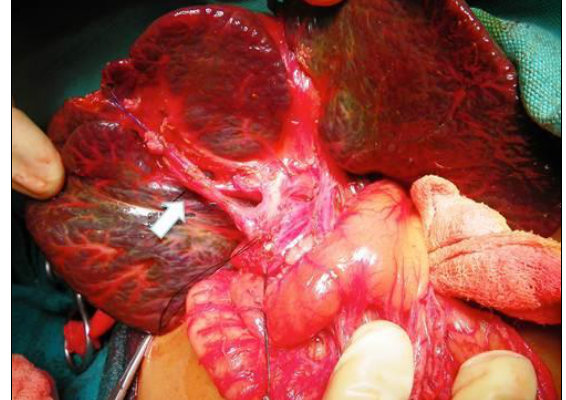
Figure 1: Intraoperative picture showing a cir- rhotic liver with a long gall bladder (block ar- row) and patent CBD.